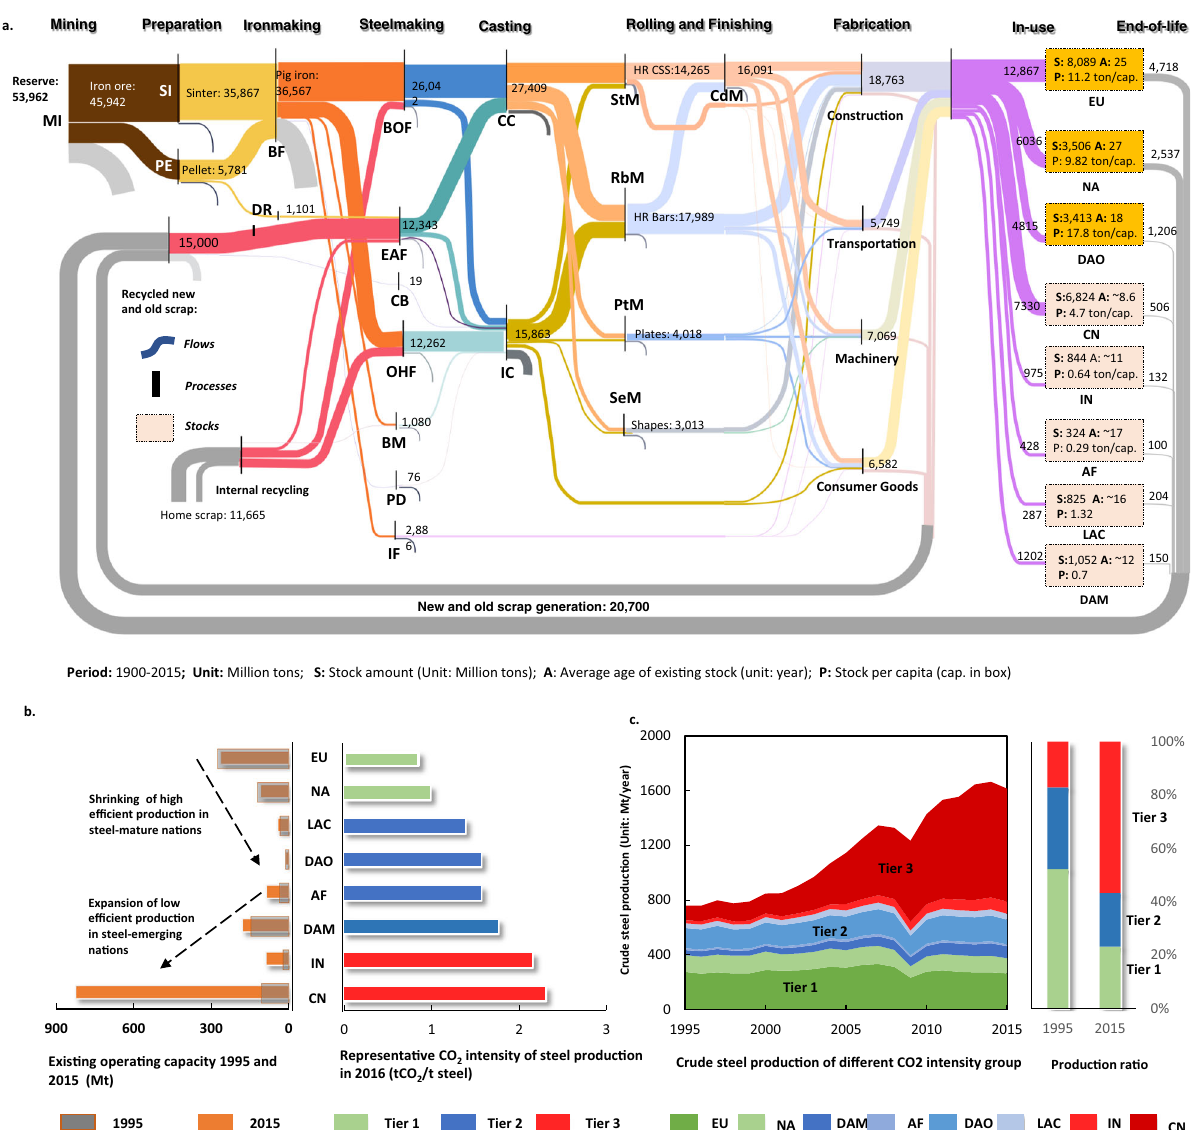
Fig. 3 Historical steel fl ows and stocks along with its life cycle, and the recent trend of regional fl ows since 1995. a The global historical steel cycle in a Sankey diagram where the numbers represent the accumulated annual fl ows over the past 115 years. b The change in operating production capacity for each studied region between 1995 and 2015, which is assumed to equal annual crude steel production based on data from World Steel Association yearbook 73 . The CO 2 intensities of these regions are obtained based on the benchmark investigation of Global Ef fi ciency Intelligence 45 where only a limited number of nations is collected for the comparison of the situation 45 in the year 2016. The boundary for this calculation differs from ours, so we only categorised these nations into three ef fi ciency tiers (i.e. EU and NA in tier 1, LAC, DAO, AF and DAM in tier 2 and IN and CN in tier 3) for indicative analysis. c The annual trend of steel production in the studied regions, which demonstrates that the historical growth in production fl ow was driven by the emerging nations (China, India, etc.) with poor ef fi ciency performance (described in Section S4.3) as shown in their share change between 1995 and 2015. The abbreviations for regions are: EU Europe, NA North America, DAO Developed Asia and Oceania, AF Africa, DAM Developing Asia and Middle East, LAC Latin America and the Caribbean, IN India, CN China. Abbreviations for steel production fl ows are: MI mining, SI sintering, PE pelleting, BF blast furnace, DR direct reduction, BOF blast oxygen furnace, CB crucible, PD puddling, BT Bessemer & Thomas, OHF open-hearth furnace, IF iron foundry, EAF